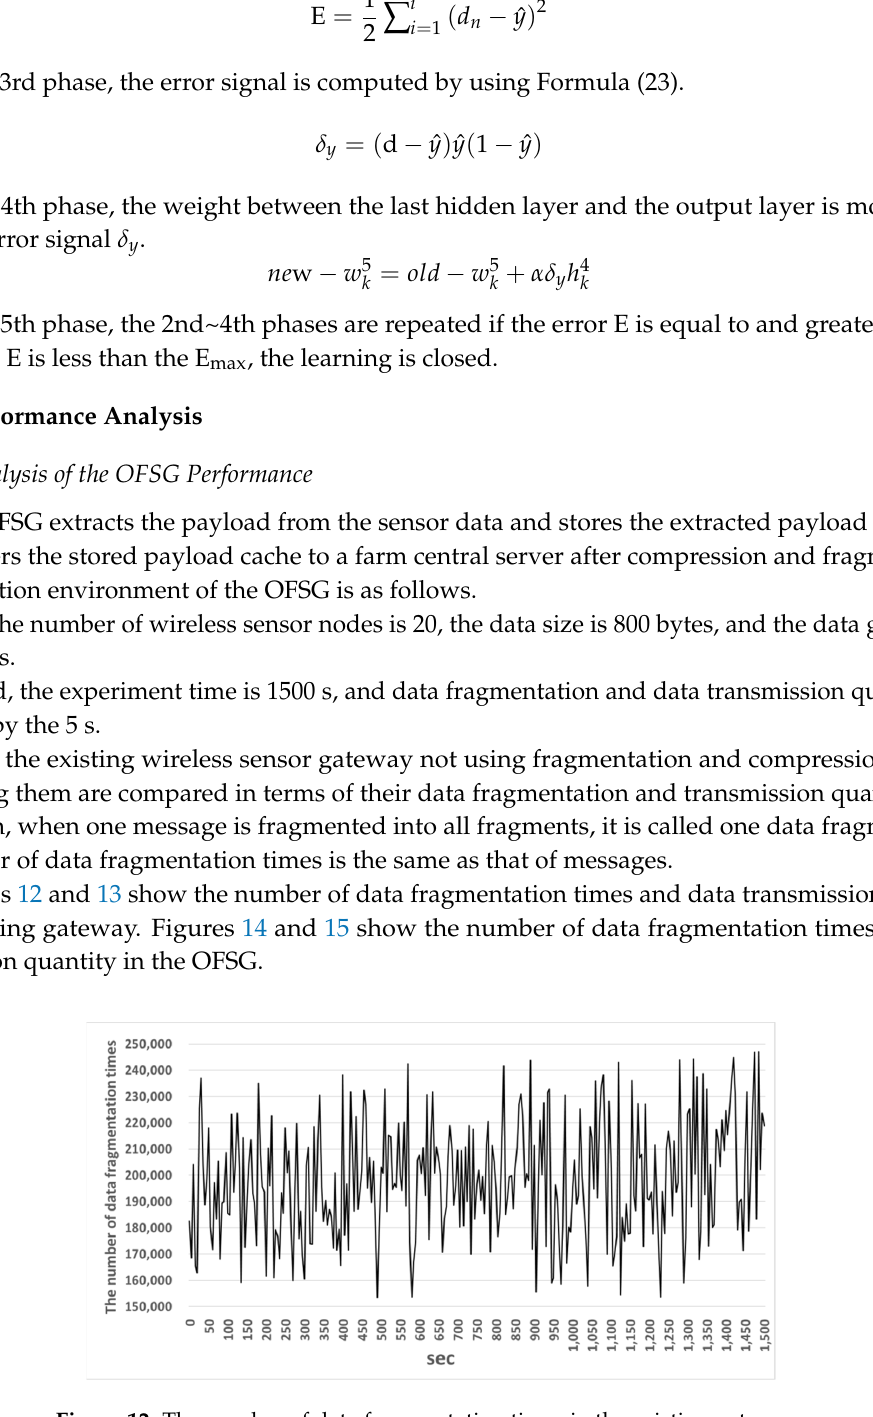
Figure 13. Data transmission quantity in the existing gateway.